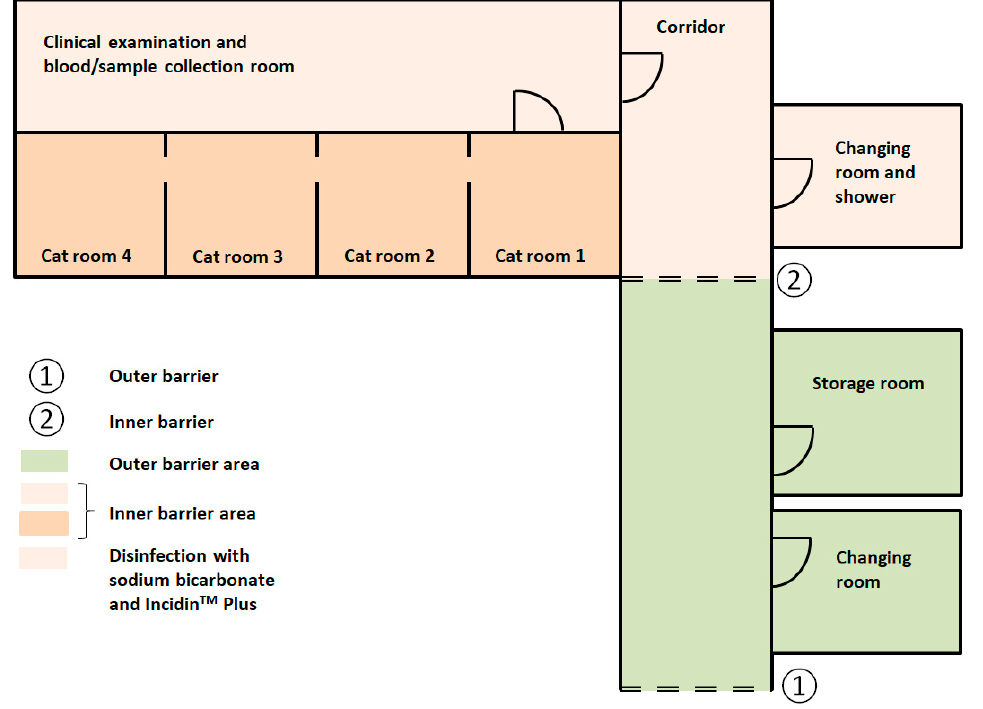
Figure 3. Schematic plot of the cat facility floor plan. The cats were housed in the combined